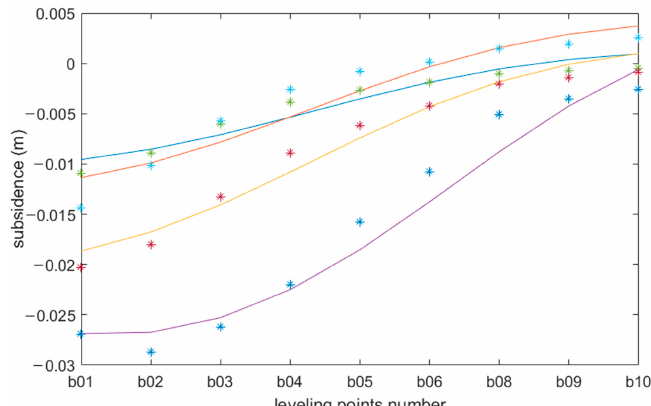
Fig 12 Figure 12. Comparison between leveling data and SBAS-InSAR results. “*” are the leveling data, and “-” are the results derived by the proposed method. Different colors denote different acquisition